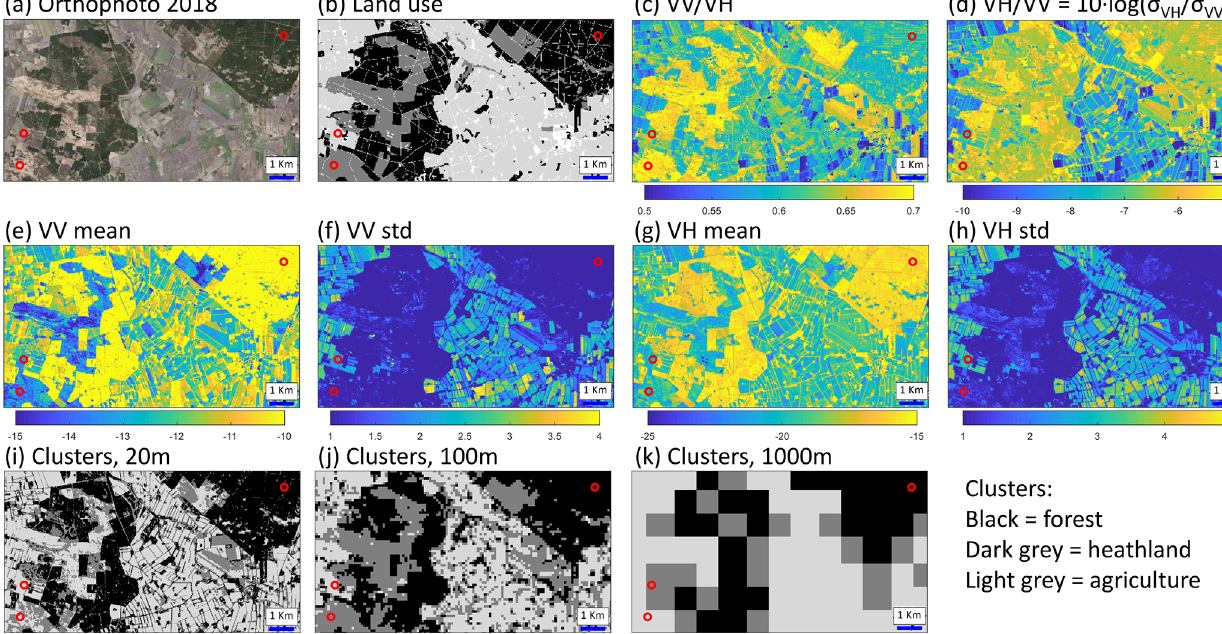
Figure 4. (a) Orthophoto (GeoDanmark data, 2018) of the study area (as in Fig. 1c). (b) Land use map (aggregated based on Levin et al., 2017) at a resolution of 10m; agriculture (light grey), heathland (grey), forest (black), cities and roads (white). (c) Cross-ratio in [dB]. (d) Cross-ratio in original backscatter. (e–h) Mean and standard deviation of Sentinel-1 co- and cross-polarization images at a 20m scale. (i–k) Clustering results at different scales (20, 100 and 1000m). Locations of CRNS stations indicated by red circles in all panels.